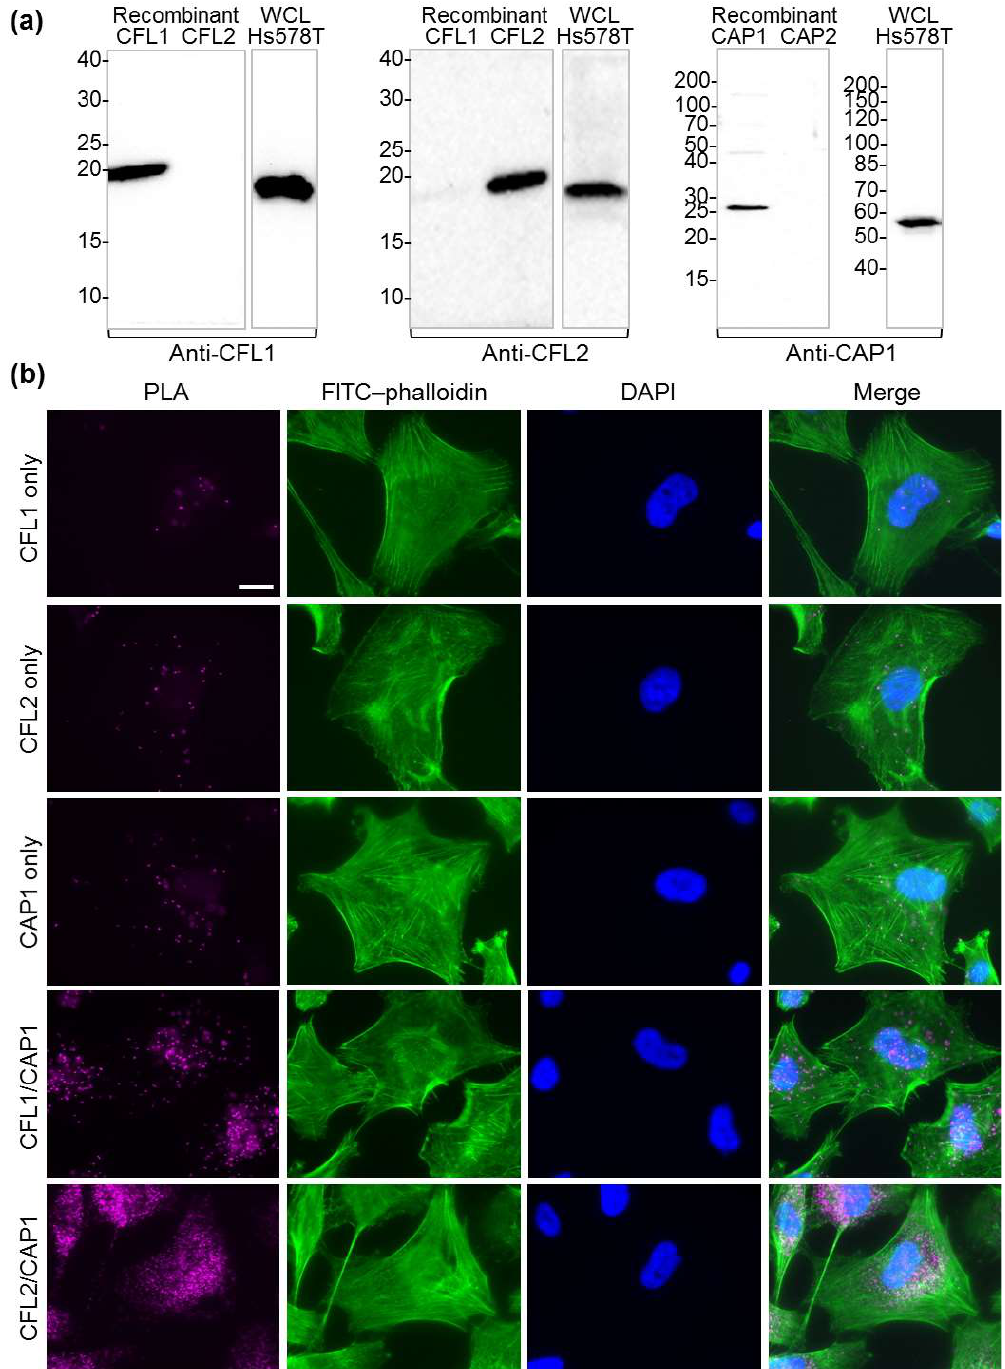
Figure 7. Interaction of native CAP1 with cofilin isoforms in cells: ( a ) western blot analysis demonstrates the specificity of the primary isoform-specific anti-CFL1, anti-CFL2, and anti-CAP1 antibodies used in immunofluorescence proximity ligation assay (PLA) experiments. WCL: whole-cell lysate. Uncropped versions of the blots are shown in Supplementary Figures S4 and S5. ( b ) Duolink in situ PLA assay performed on Hs 578T cells, as described in the Section 4.8. Cells stained using a single primary antibody (CFL1 only, CFL2 only, and CAP1 only) are shown as negative controls. PLA signal (magenta) using pairs of CFL1/CAP1 and CFL2/CAP1 antibodies represents CAP1/cofilin interaction events. Cells were counter-stained with fluorescein isothiocyanate (FITC)–phalloidin for F-actin (green) and nuclear 4′,6-diamidino-2-phenylindole (DAPI, blue). Scale bar is 20 µm.